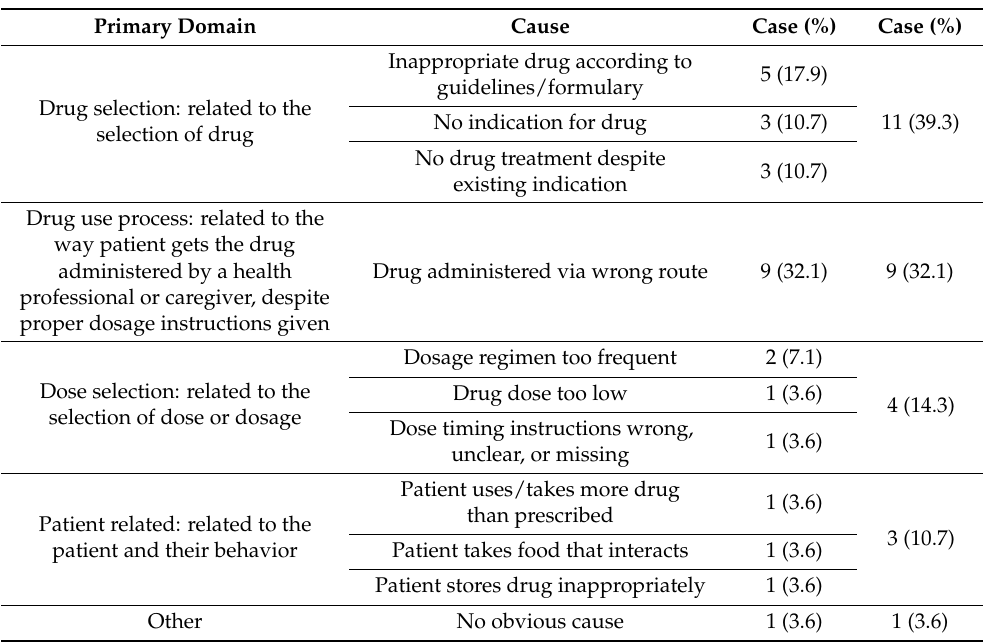
Table 3. Pharmaceutical Care Network Europe (PCNE) classification for DRPs identified in the intervention